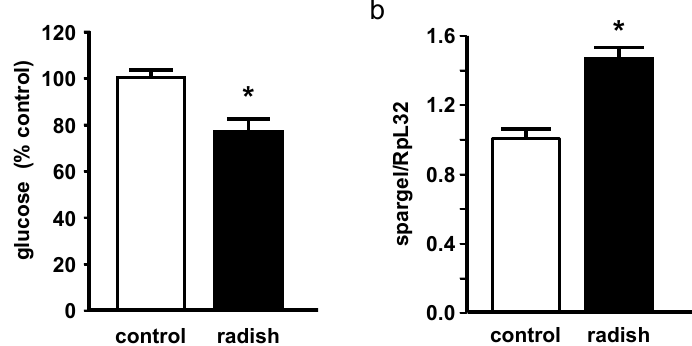
Figure 4. Effect of 10-day radish sprout supplementation on male Drosophila melanogaster. ( a ) relative glucose levels ( n = 9 + SEM; extraction from 9 × 5 flies); ( b ) relative mRNA levels of spargel related to the housekeeping gene RpL32 ( n = 3 + SEM; extraction from 3 × 5 flies). * indicates significant differences between control and radish sprout-fed flies ( p < 0.05, Student’s t -test).